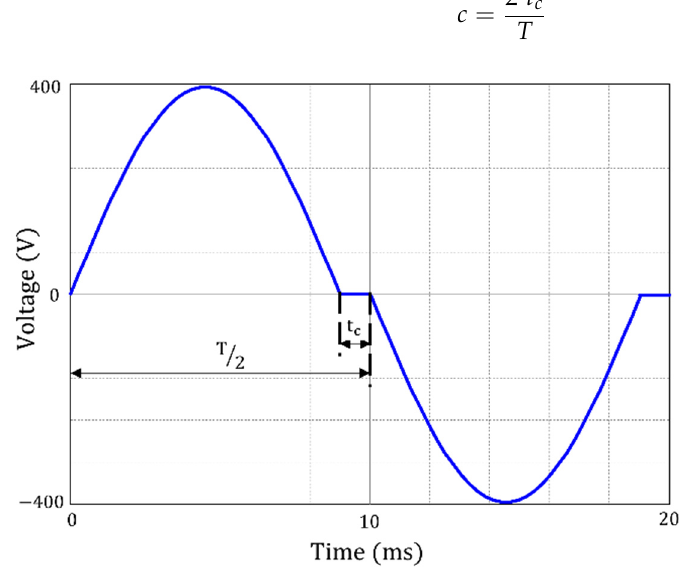
Figure 8. Sinusoidal voltage signal with zero-time perturbation.